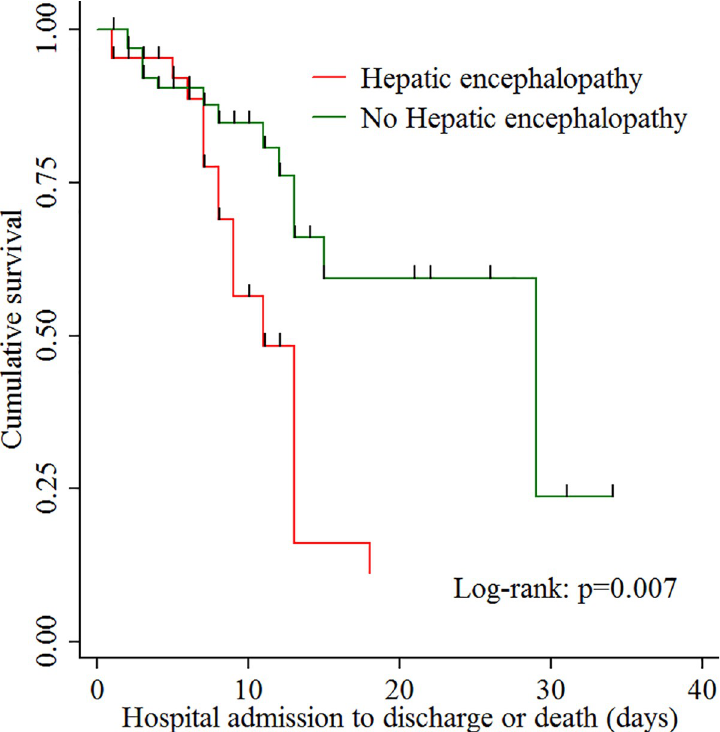
Fig 2. This is a Kaplan-Meier survival analysis of patients admitted with Chronic Liver disease (CLD) across the course of hospital stay stratified by the presence of hepatic encephalopathy. As the time of hospital stay increased, the survival of patients with hepatic encephalopathy (red line) was less than those without hepatic encephalopathy (green